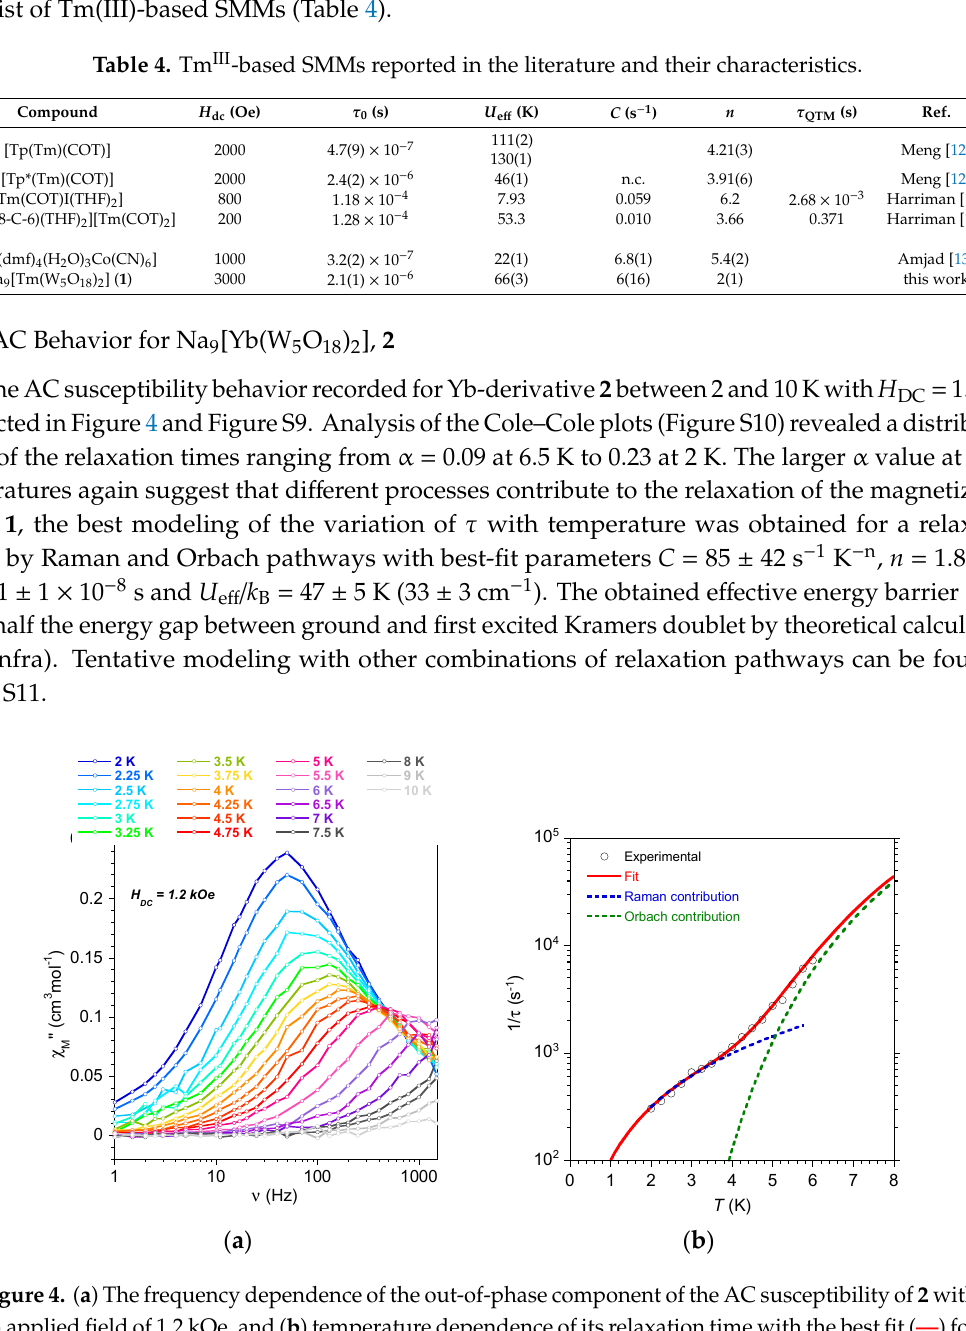
Table 4. Tm III -based SMMs reported in the literature and their characteristics. Compound